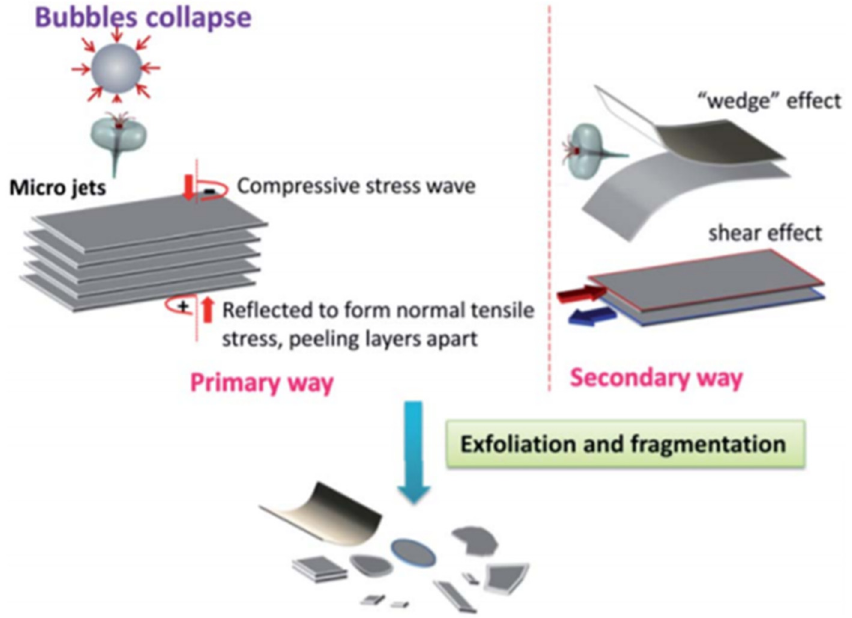
Figure 11. Schematic figure of mechanical exfoliation of graphene by sonication method. “Repro- duced with permission from [111], [Journal of Materials Chemistry A]; published by [Royal Society of Chemistry], 2015”.